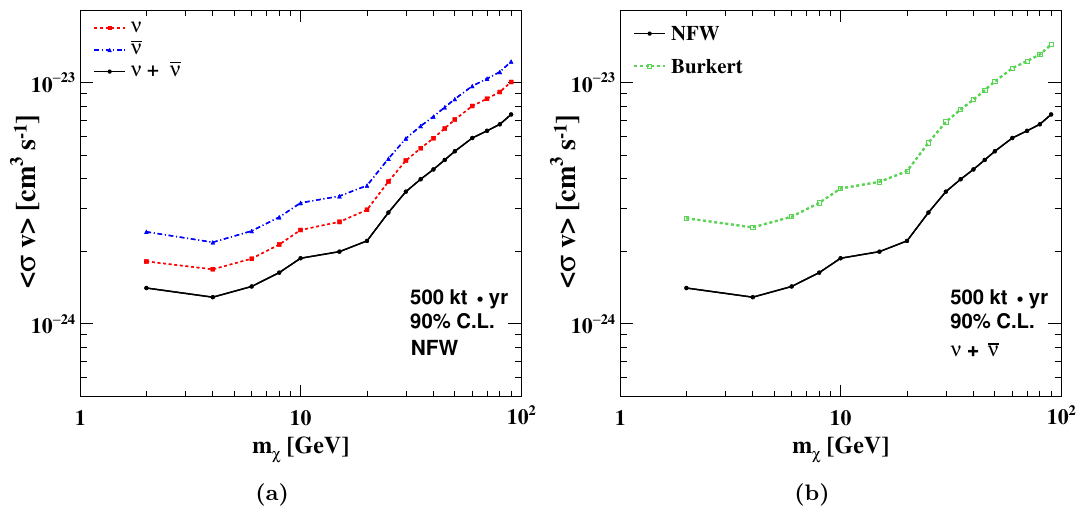
Figure 5. (a) The upper limit on self-annihilation cross-section of DM particle ( (cid:31)(cid:31) ! (cid:23) (cid:22) (cid:23) ) at 90% C.L. (1 d.o.f.) as a function of DM mass m (cid:31) using 500 kt (cid:1) yr exposure of the MagICAL